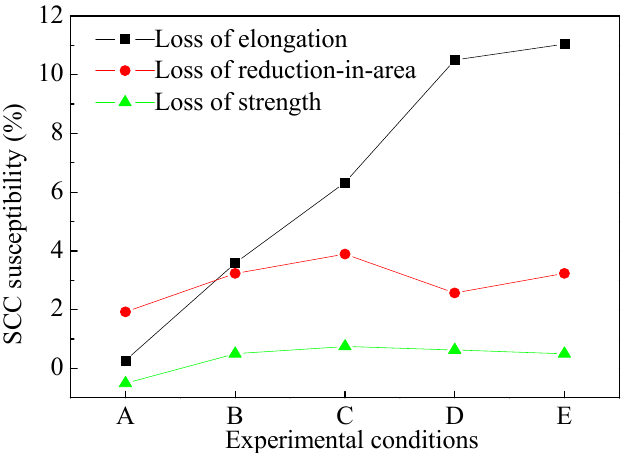
Figure 7. Variation of SCC susceptibility of L80 steel after immersion for 720 h with water content and preloading stress (A: 5 wt %, 0 σ s ; B: 80 wt %, 0 σ s ; C: 80 wt %, 0.5 σ s ; D: 80 wt %, 0.8 σ s ; and E: 80 wt %, 1.0 σ s ).